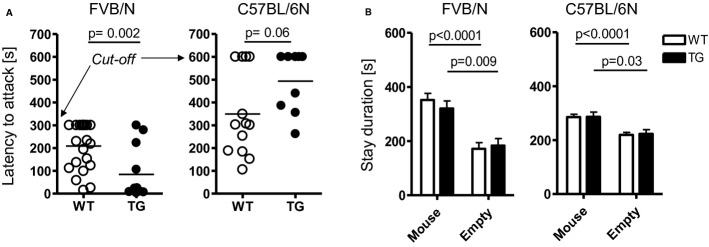
Territorial aggressive behavior in male mice is influenced by Mecp2 overexpression and genetic background.A Latency to attack in the resident-intruder test is significantly reduced in male FVB/N TG mice but increased in C57BL/6N. Note the different cut-off for the 2 strains.B Sociability testing in the tripartite chamber reveals a highly significant preference of male mice, independent of the genetic background, for a stranger mouse as compared to an object (empty cage).Data information: N = 10–24; mean ± s.e.m. given.